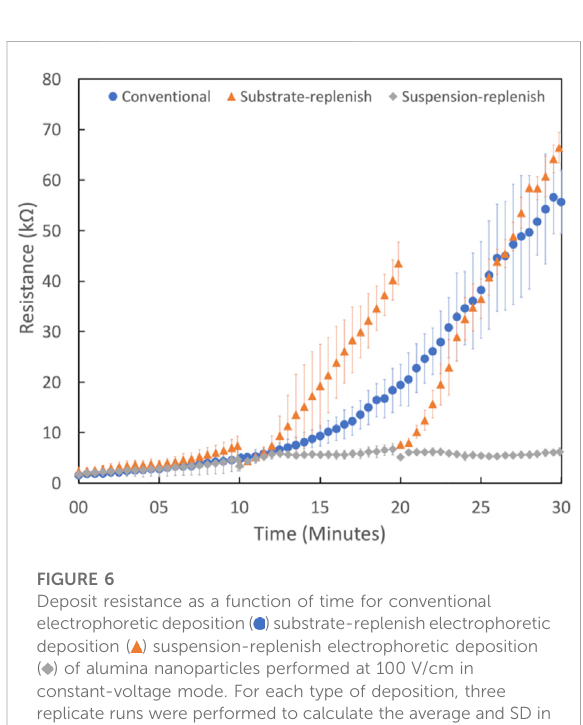
FIGURE 6 Deposit resistance as a function of time for conventional electrophoreticdeposition( )substrate-replenishelectrophoretic deposition ( ) suspension-replenish electrophoretic deposition ( ) of alumina nanoparticles performed at 100 V/cm in constant-voltage mode. For each type of deposition, three replicate runs were performed to calculate the average and SD in deposit resistance plotted